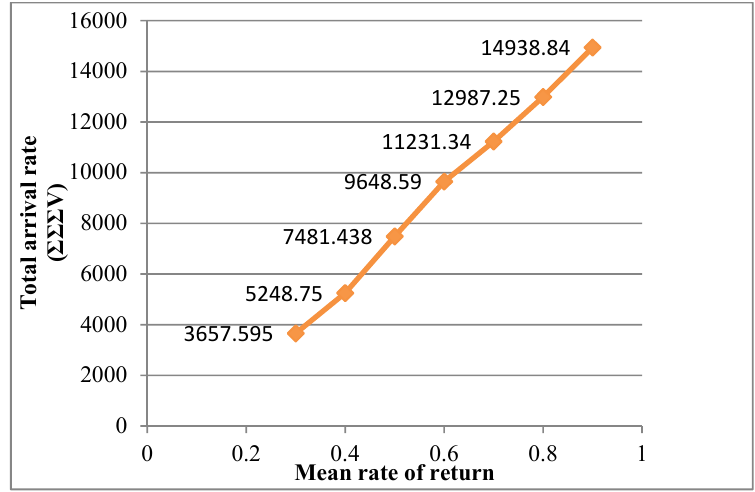
Fig. 2. Total arrival rate vs. mean rate of return